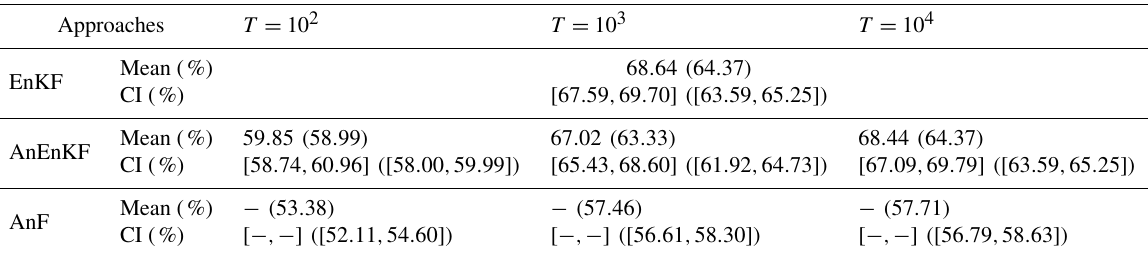
Figure 2. Simulated trajectories (a) and bivariate distributions (b) from the modified Lorenz-63 model Eq. (16) with λ = 0 and λ = 8. The observations (dots) are generated with the correct model with λ = 0 and an additive Gaussian noise with mean 0 and variance 2 I 3 . Figure obtained using a time step d t = 0 . 01. Table 1. Sensitivity of the percentage of correct model identification based on the CME and on the RMSE (values within parentheses) with respect to the length of the catalog (T ) used in the AnEnKF and in the AnF. The mean and 95% confidence interval (CI) of the percentage of correct model identification are computed for each of the algorithms using 10 repetitions of the assimilation